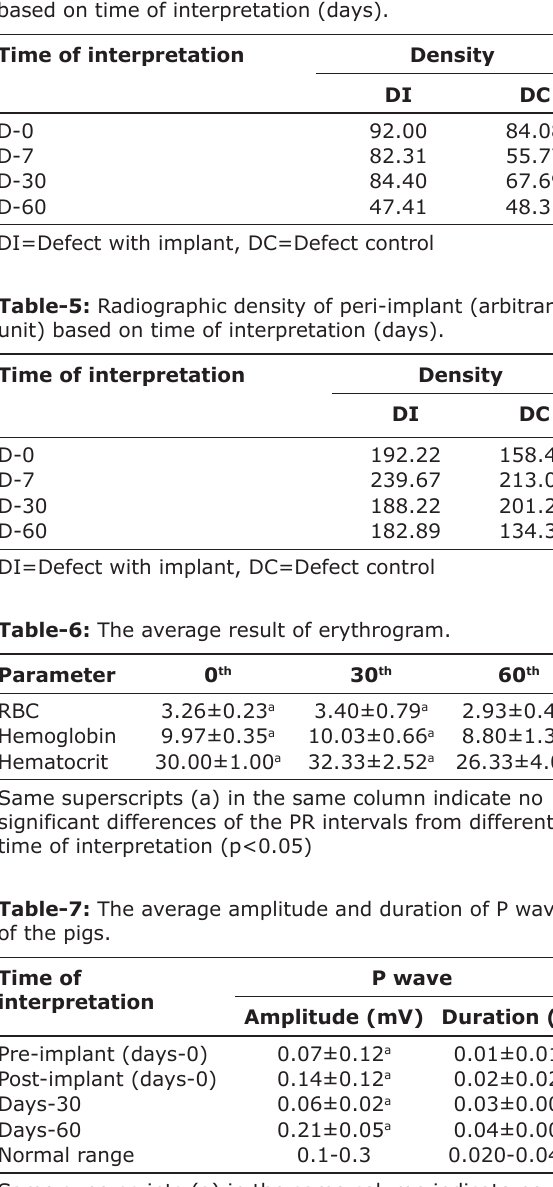
Same superscripts (a) in the same column indicate no significant differences of the PR intervals from different time of interpretation